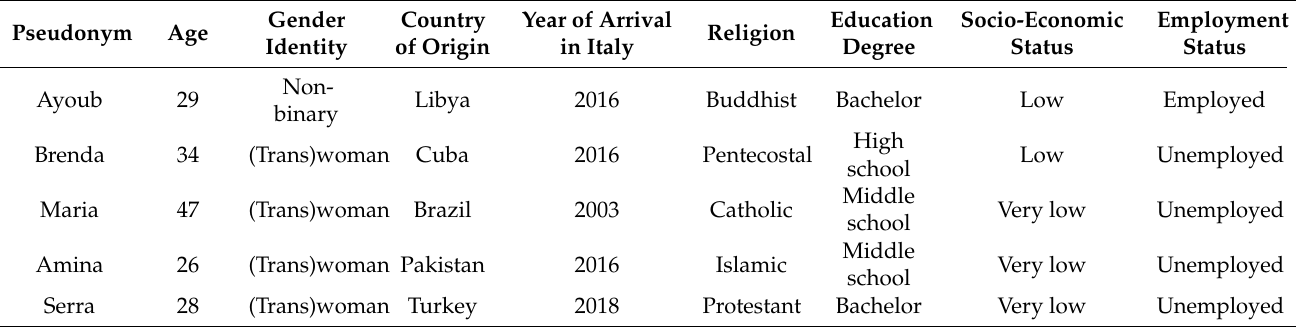
Table 1. Participants’